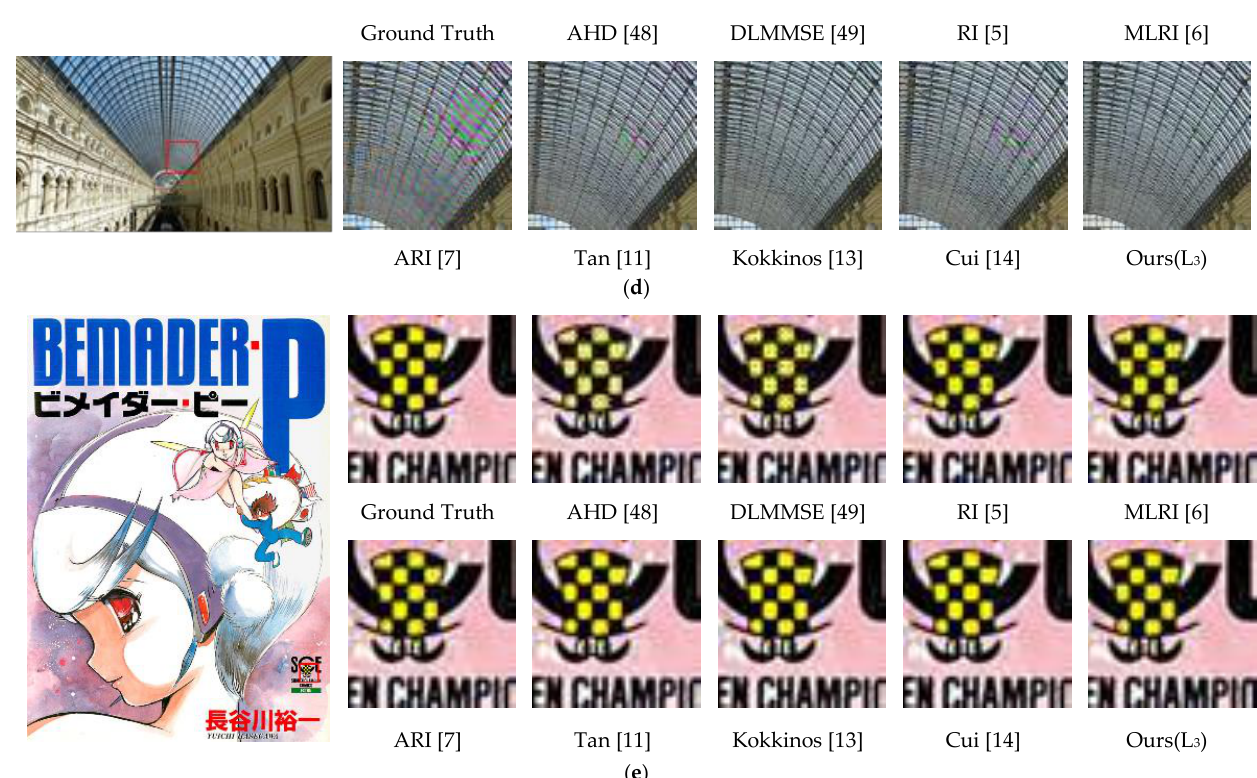
Figure 5. Visual comparison of the demosaicking results on 5 representative images in Kodak, McMaster, Urban100, and Manga109. ( a ) ‘kodim19’ from Kodak [44]. ( b ) ‘kodim08‘ from Kodak [44]. ( c ) ‘1’ from McMaster [45]. ( d ) ‘img_008’ from Urban100 [46]. ( e ) ‘BEMADER_P’ from Manga109 [47].